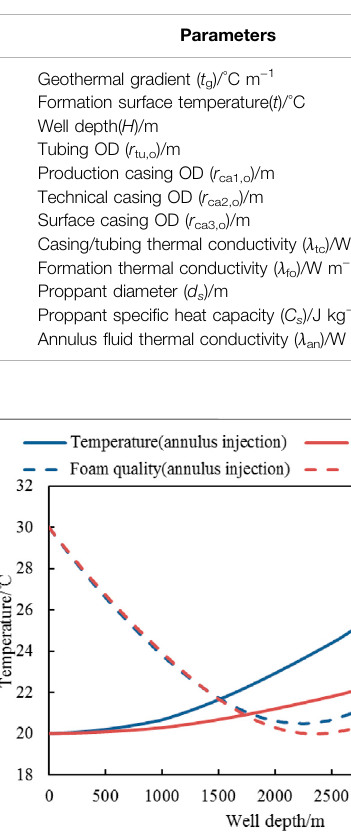
TABLE 2 | The basic parameters of calculation.